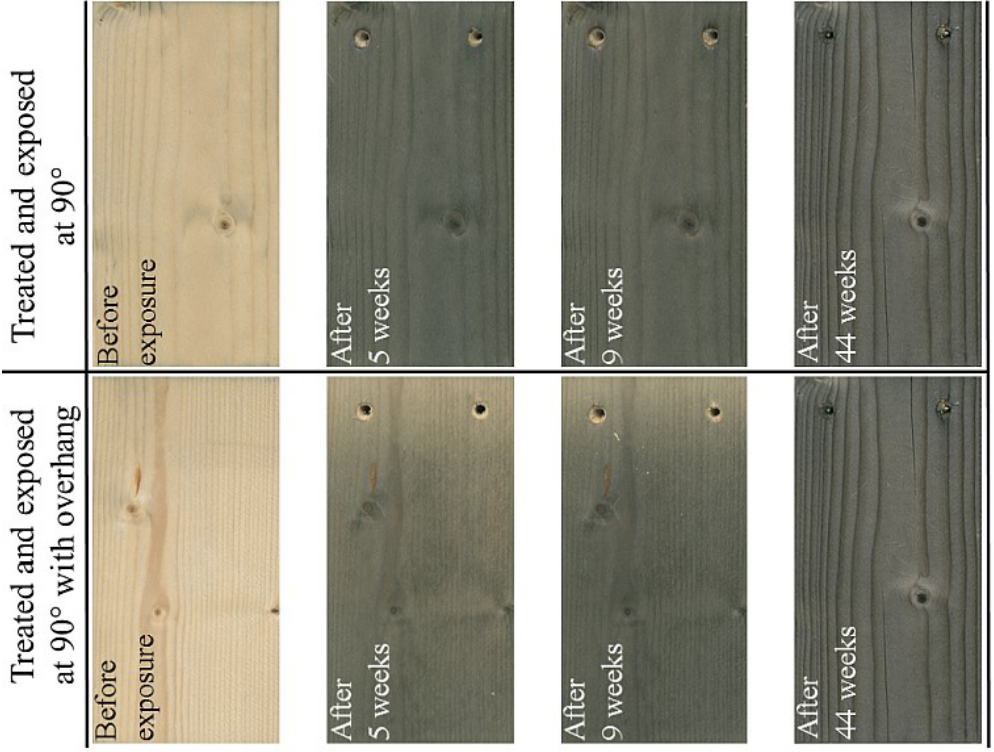
Figure 7. Spruce specimens treated with iron (II) sulfate of sample set 3 exposed at 90° with and without protection by an overhang before and after 5, 9, and 44 weeks of exposure to the south.